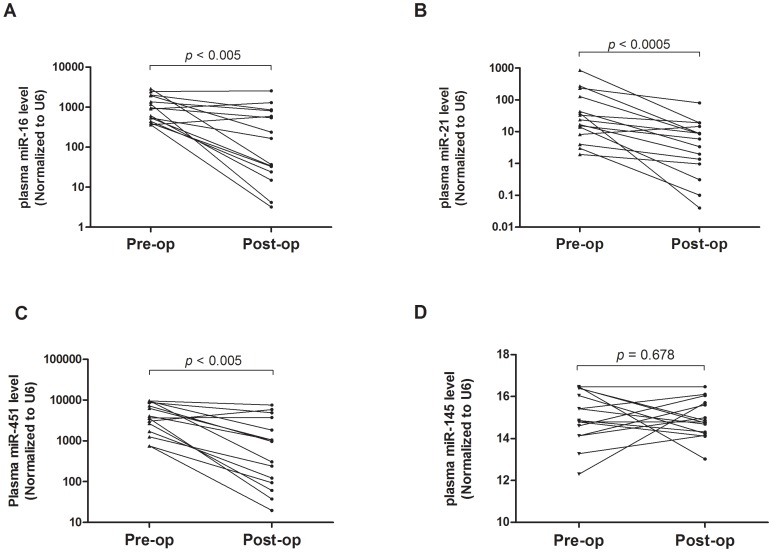
MicroRNA selection and validation by quantitative RT-PCR analysis.Changes of plasma levels of (A) miR-16, (B) miR-21, (C) miR-451 and (D) miR-145 in breast cancer patients (n = 15) before (pre-Op) and 14 days after (14 day post-Op) surgical removal of the tumor. Expression levels of the miRNAs (Log10 scale at Y-axis) are normalized to RNU6B. Statistically significant differences were determined using Wilcoxon tests.